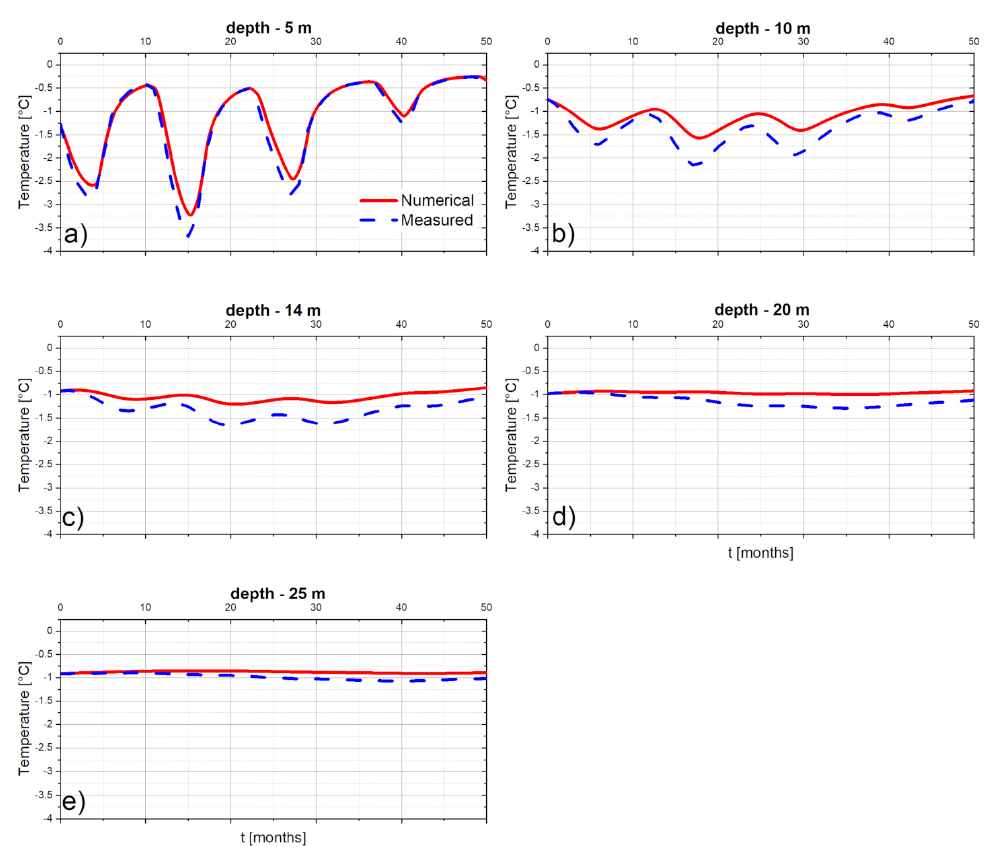
Figure 8. Comparison of temperature variations with time for different depths: ( a ) z = 5 m, ( b ) z = 10 m, ( c ) z = 14 m, ( d ) z = 20 m and ( e ) z = 25